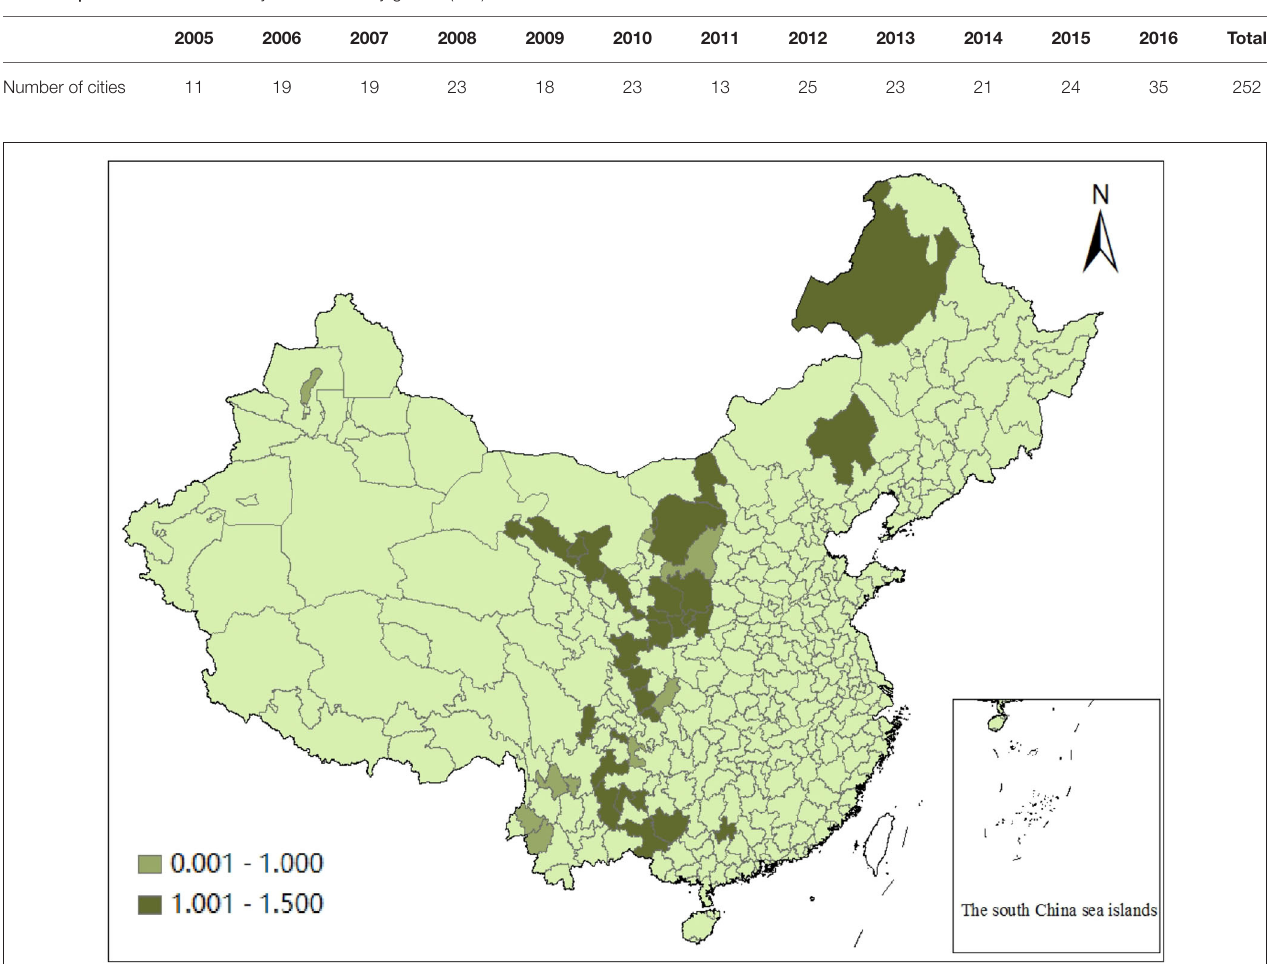
TABLE 3 | Number of cities with dynamic efficiency growth ( > 1) from 2005 to 2016.